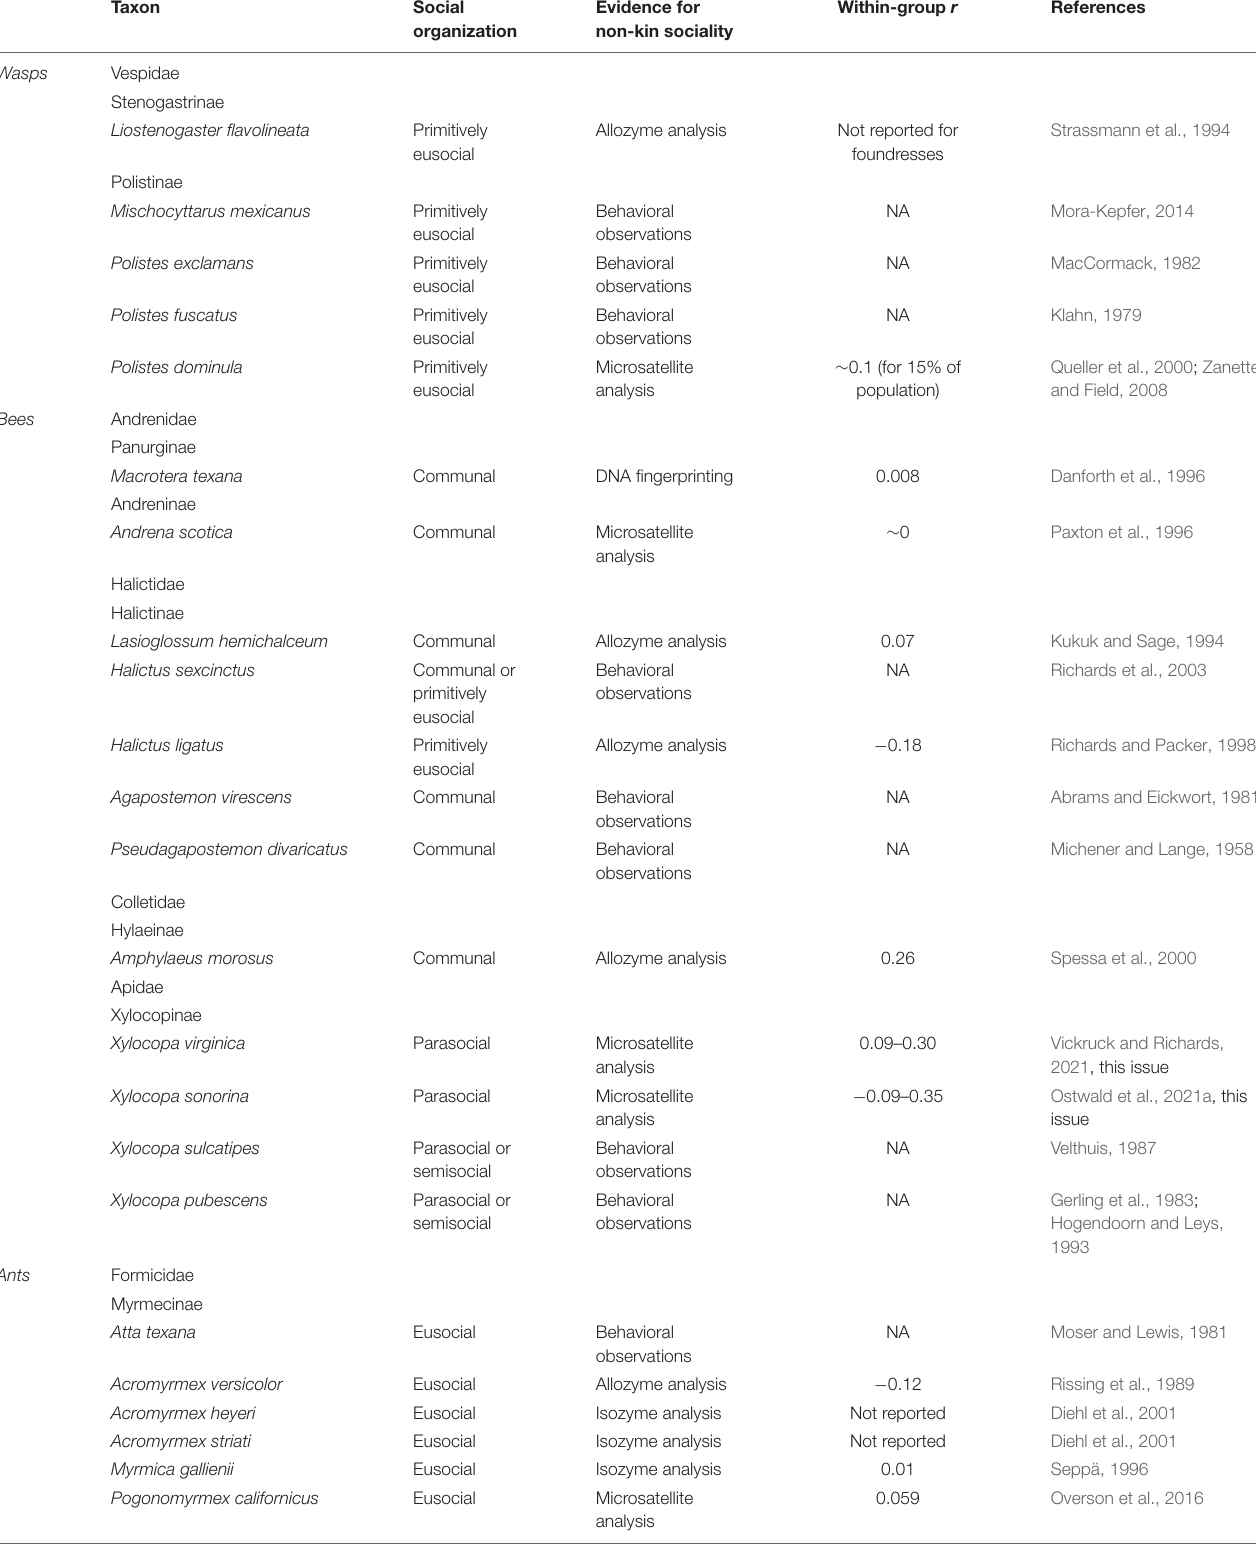
TABLE 1 | Hymenopteran species with the strongest evidence for non-kin